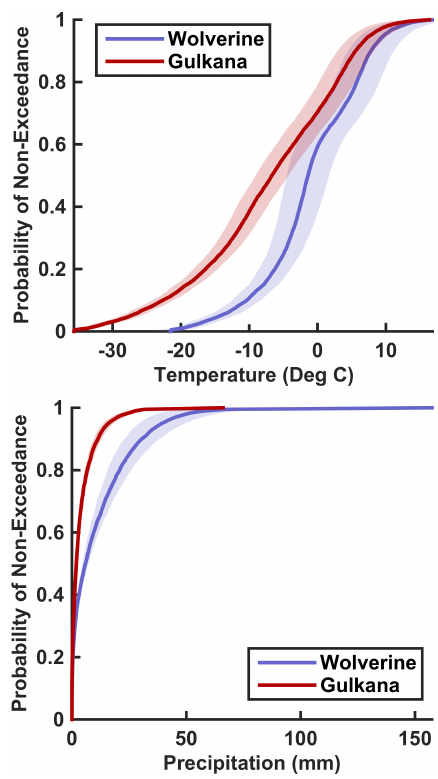
Figure 2. Cumulative probability distributions of daily precipita- tion and mean surface air temperature for the Gulkana and Wolver- ine watersheds (Fig. 1) from 1980 to 2009. The lines correspond to the spatially averaged precipitation and temperature values and the shaded region indicates 1 standard deviation in the spatial distribu- tion of precipitation and temperature within the watershed. Climate representation is derived from the daily downscaled Climate Sys- tem Forecast Reanalysis (Saha et al., 2010) product discussed in Sect.